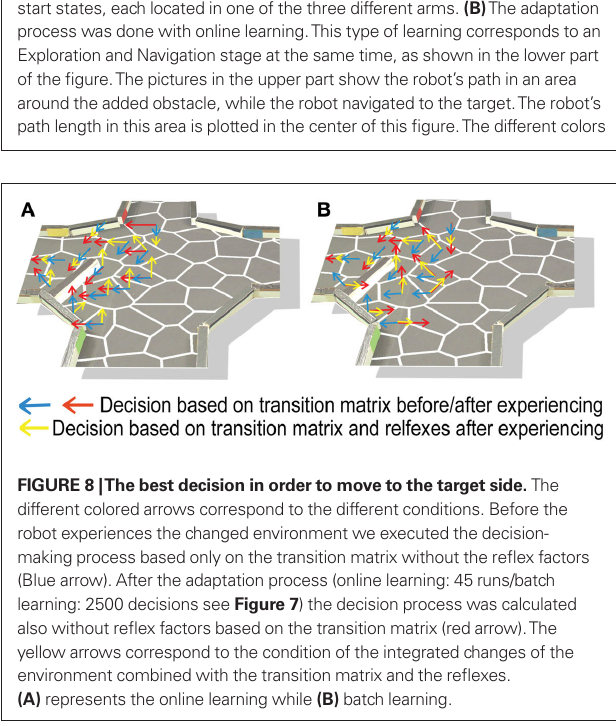
correspond to the robot’s start position in the different arms as shown in (A) . The brown line corresponds to the best approximation of the path length of all runs by an exponential combined with a constant. (C) The adaptation process using batch learning. After some action executions done in one of the 22 states surrounding the construction side the path of the robot from three different start states to one target side was evaluated. The robots path is shown in the upper part of the figure, for different number of experiences. In the lower part the best decision in order to move to the goal is shown for each state for a different number of experiences.